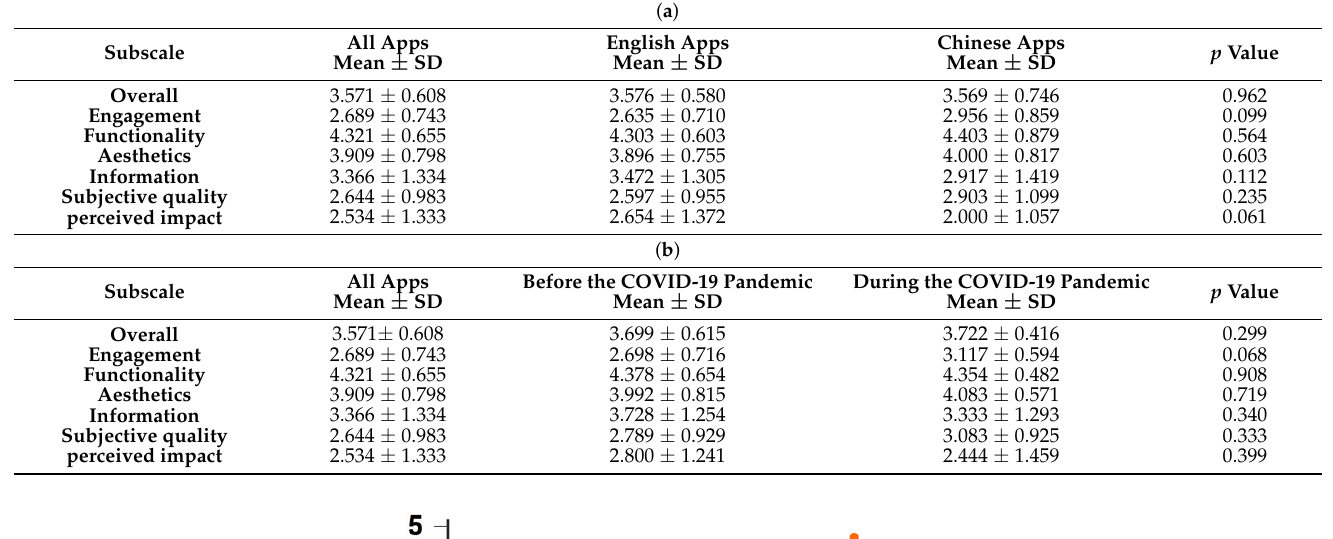
Table 2. Quality of ADRD applications measured by the Mobile Application Rating Scale (MARS) in ( a ) all and English vs. Chinese apps, ( b ) before and during COVID-19 pandemic. ( a )